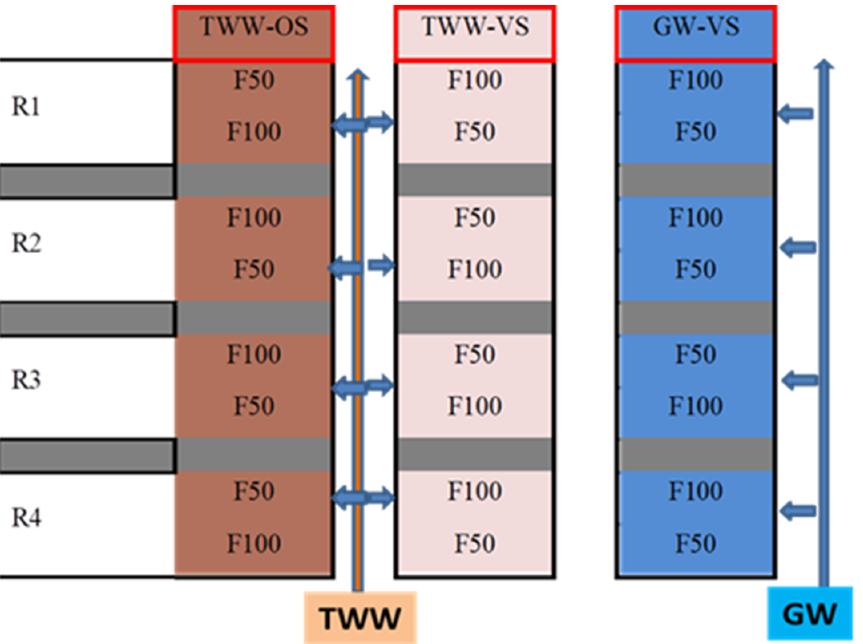
Figure 1. Layout of an experimental design that applied for each crop in each season and includes three irrigation treatments (irrigation with treated wastewater in old cultivated soil (TWW-OS), irrigation with treated wastewater in virgin soil (TWW-VS) and irrigation with groundwater in virgin soil (GW-VS); two fertilizer treatments {half (F50) and full recommended dose of NPK (F100)}. R, replication.